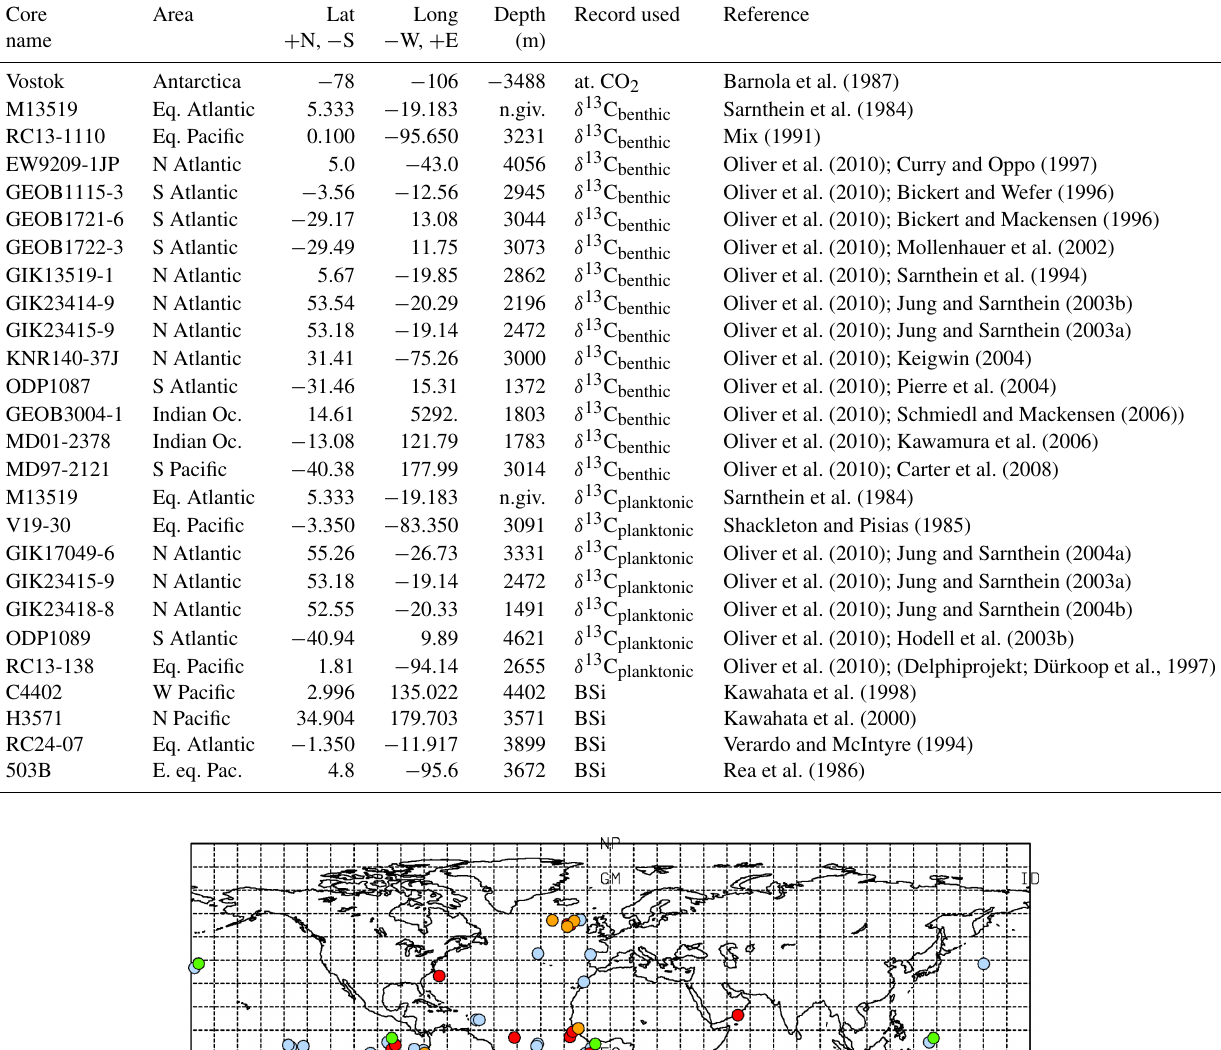
Table 3. Marine sediment core data and ice core data which were used for determining the parameter changes through a fit of the linear response model. Most data sets were taken from the data synthesis by Oliver et al. (2010) as indicated below. (For CaCO 3 data, see Table 4.)